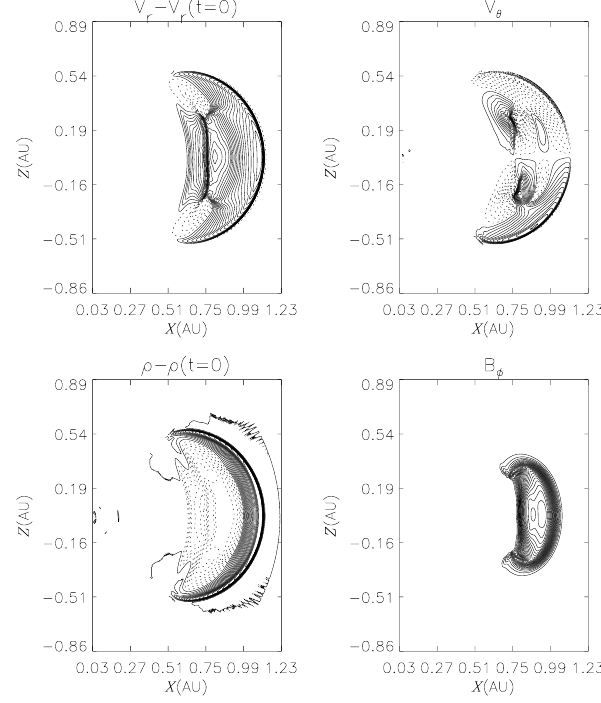
Fig. 4. The plasma properties of the ICME projected onto the r − θ plane for a case where the initial ICME moves at twice the solar wind speed. The four panels show the change in V r relative to the initial velocity, the angular velocity (V θ ), the change in the den- sity with respect to the initial value, and the magnitude of B φ , 2.57 days after the initiation. Solid (dashed) lines indicate positive (neg- ative) contours. The maximum (minimum) contour values are 106 (31)km/s, 31 ( − 31)km/s, 120% ( − 80%) and 10.63 (0)nT, respec-